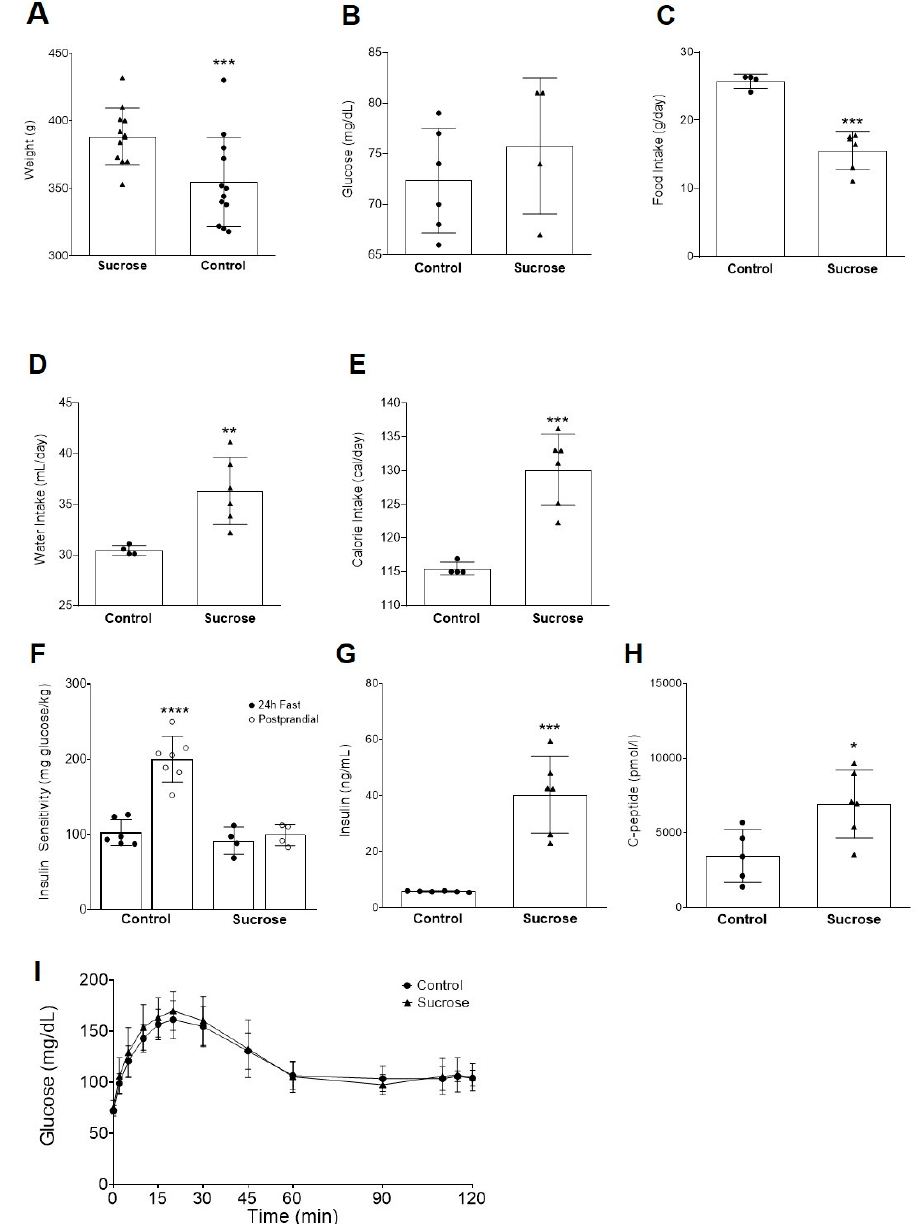
Figure 1. E ff ect of high-sucrose feeding on metabolic parameters, insulin sensitivity, and whole-body homeostasis in male Wistar rats. ( A ) Body weight; ( B ) fasting blood glucose; ( C ) food intake; ( D ) water intake; ( E ) calorie intake; ( F ) control and sucrose groups insulin sensitivity—fast and postprandial; ( G ) serum insulin levels; ( H ) serum C-peptide levels; and ( I ) meal tolerance test—MTT. Food, water,